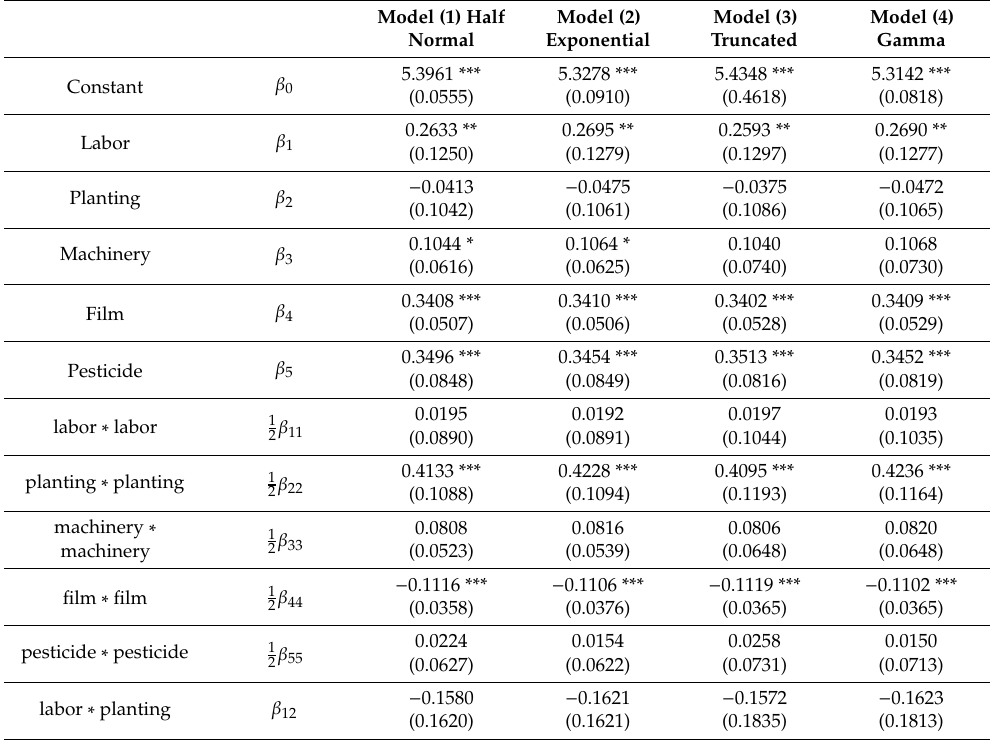
Table 2. Stochastic frontier approach (SFA) model parameter estimation